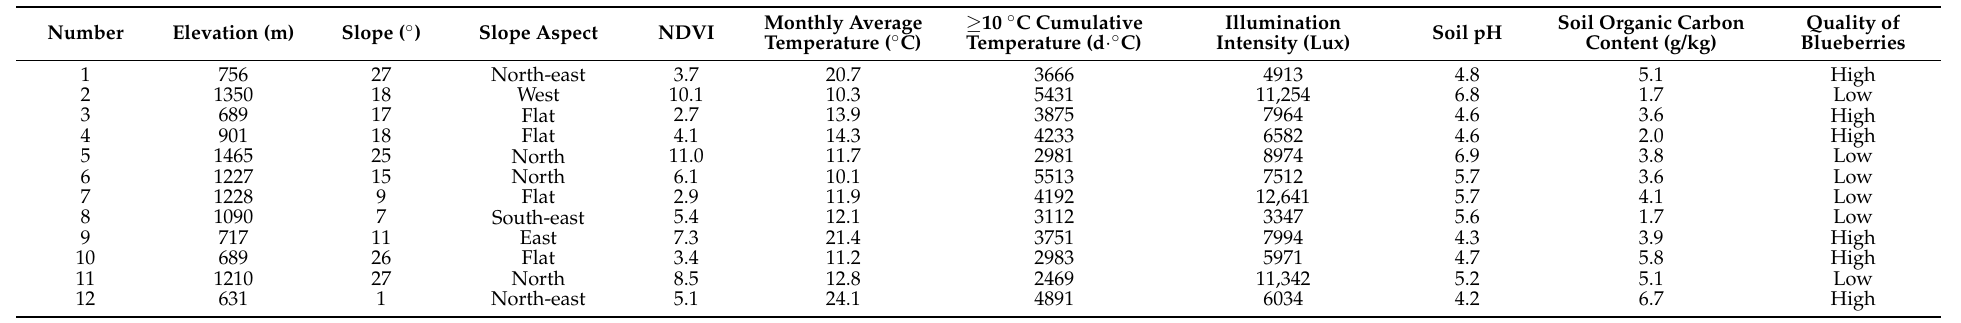
Table 2. Partial sample data.